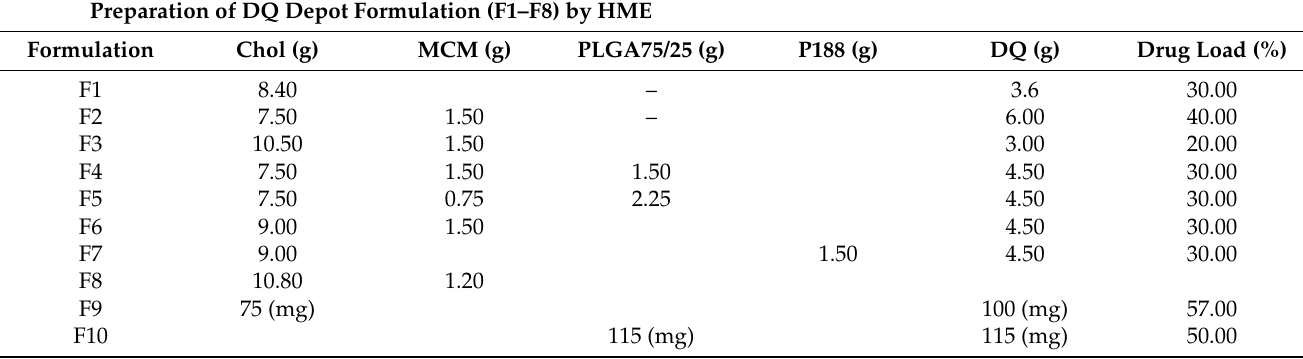
Table 1. Compositions of